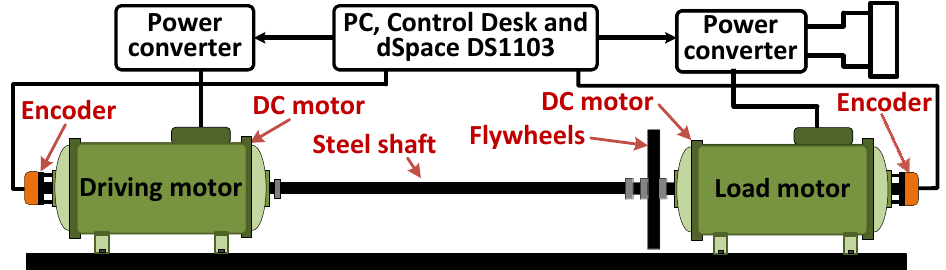
Figure 8. Laboratory set-up: schematic block diagram and real view.